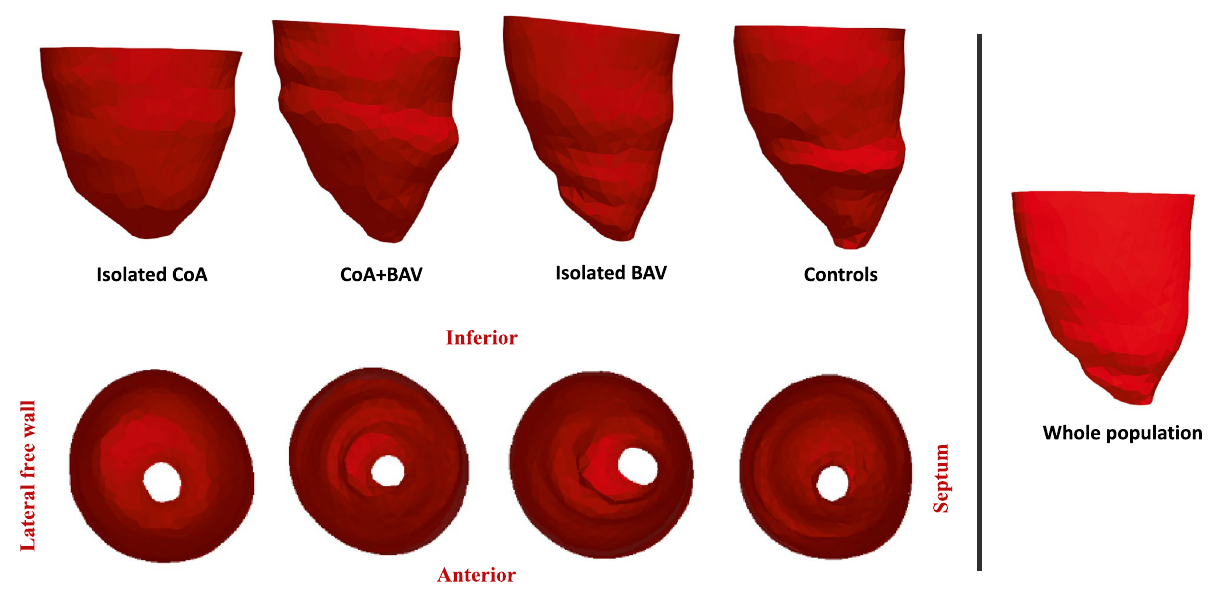
Figure 3. LV shape templates, showing the average 3D configuration of the ventricles. As labelled, the figure illustrates the average shapes of each group separately, both side and top views. The whole population template is also